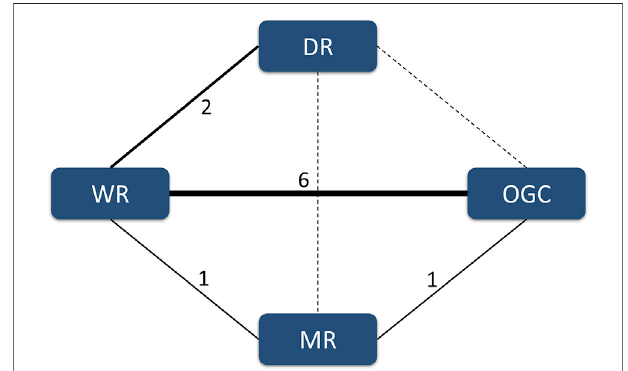
FIGURE 3 | Evidence structure of available comparisons. The solid line indicates the presence of a direct comparison of two regimes, and the dotted line suggests the absence of a direct comparison between two regimes. The width of the solid line is positively related to the accumulated number of eligible studies.